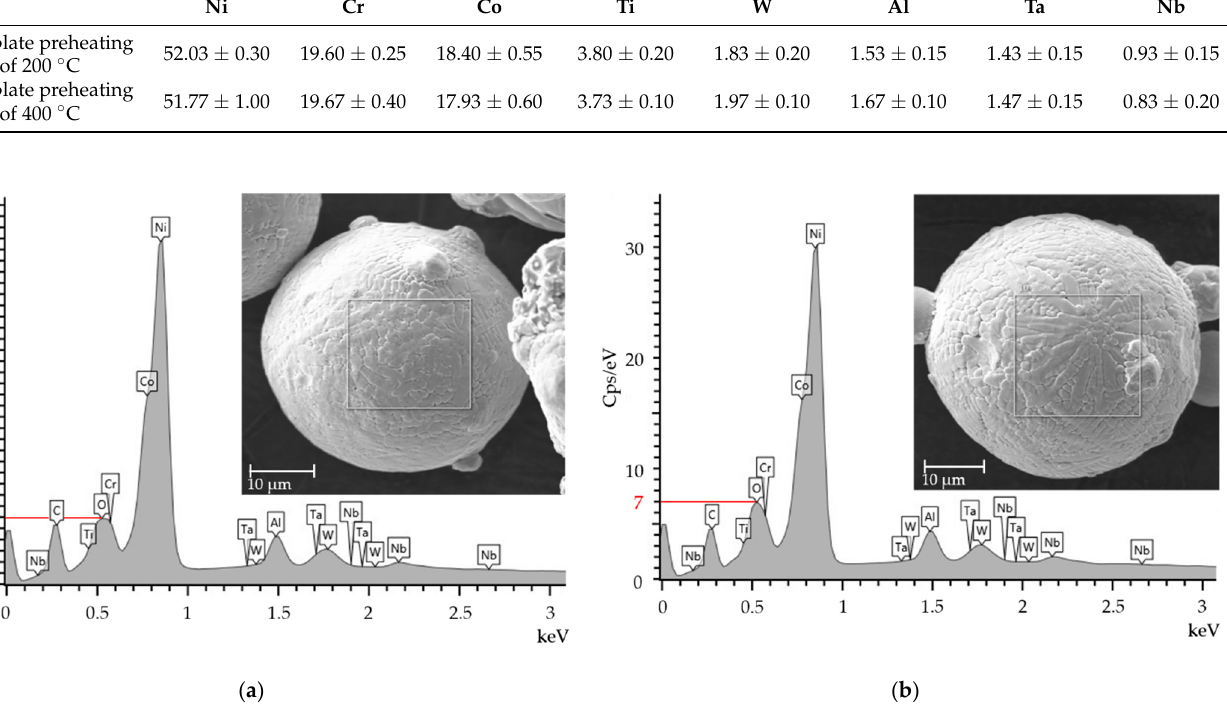
Figure 10. EDX analysis of the IN939 powder before and after using at high-temperature preheating. The white rectangle on powder grains symbolise the measured area. ( a ) Unused virgin powder; ( b ) used powder with the base plate preheated at 400 °C for 2 h.